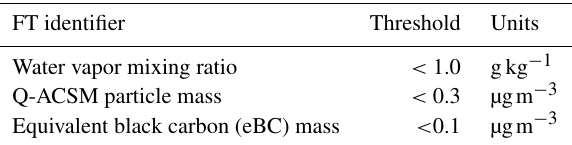
Table 2. Identified threshold values to determine periods with free tropospheric (FT) air from higher altitudes reaching CHC undis- turbed by mixing with the local boundary layer during the dry sea-